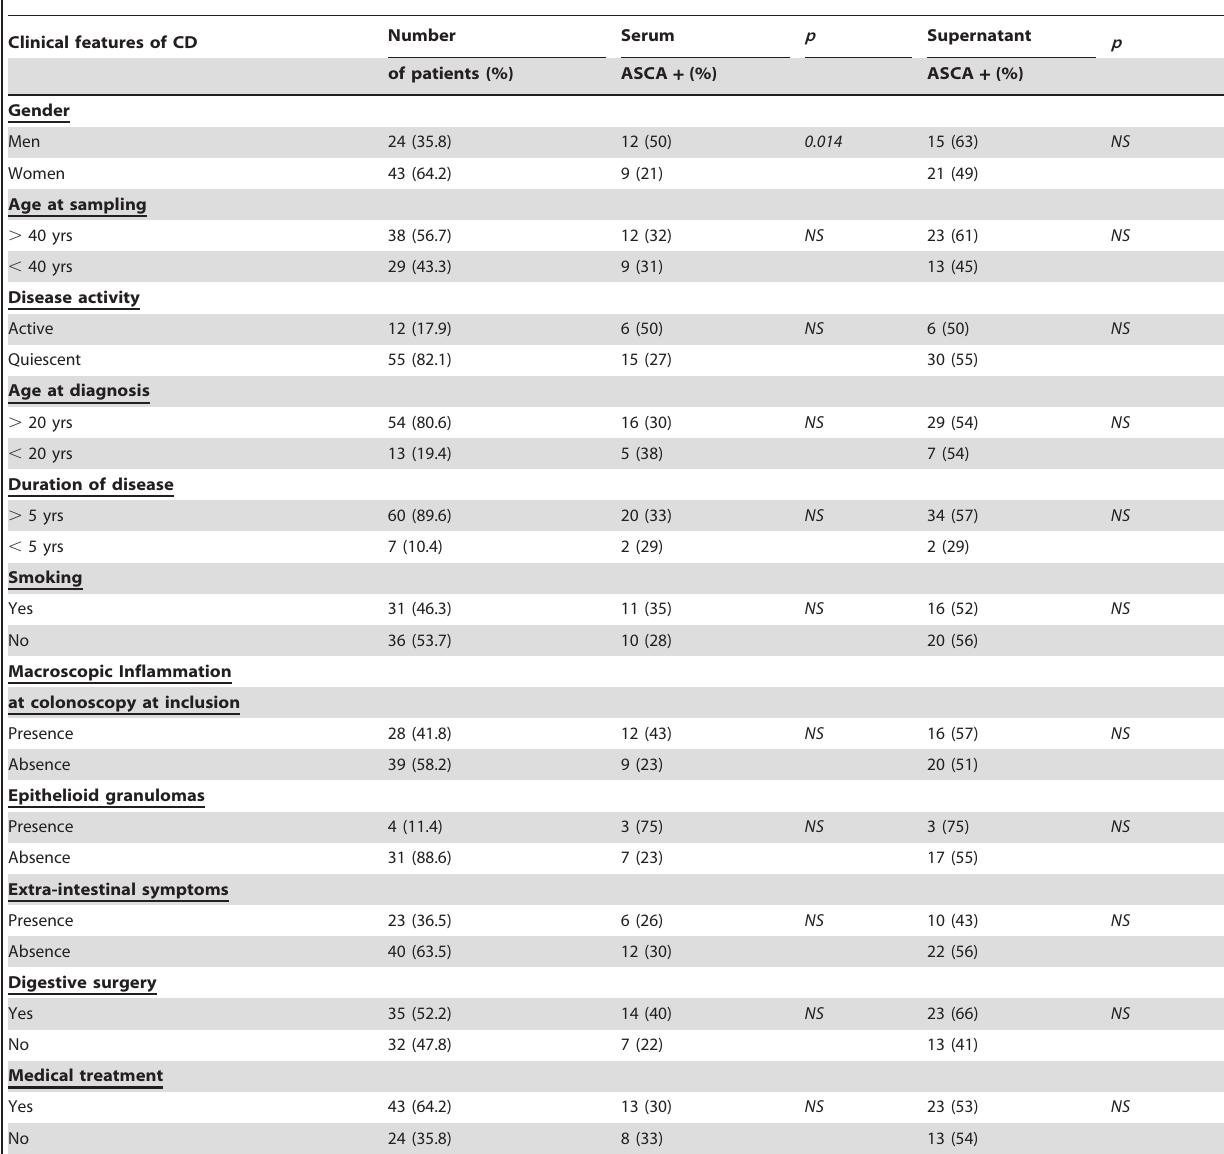
Table 3. Study of correlation between ASCA status and CD clinical features.